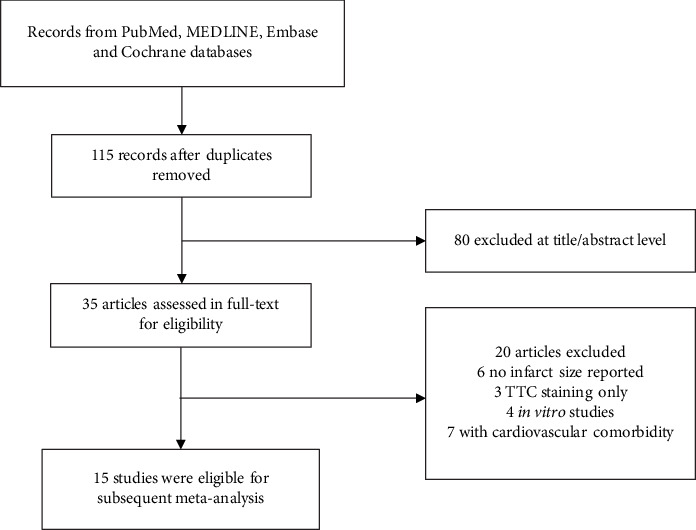
Flow diagram of the study inclusion.